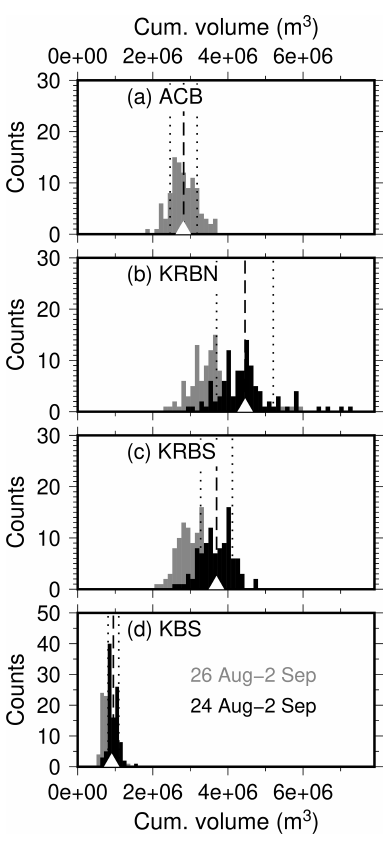
Figure 4. Distribution of cumulative ice volumes between 24 Au- gust and 2 September using the best GLMs in Fig. 3 that are trained with 80% (randomly selected) of the calibration data in 100 runs (black histograms). The triangle overlying the histogram at the bot- tom is volume obtained with the model calibrated with the full data set. Gray histograms correspond to hydroacoustic recording period (from 26 August). Vertical lines indicate means (dashed) and stan- dard deviation (dotted) obtained from the volume